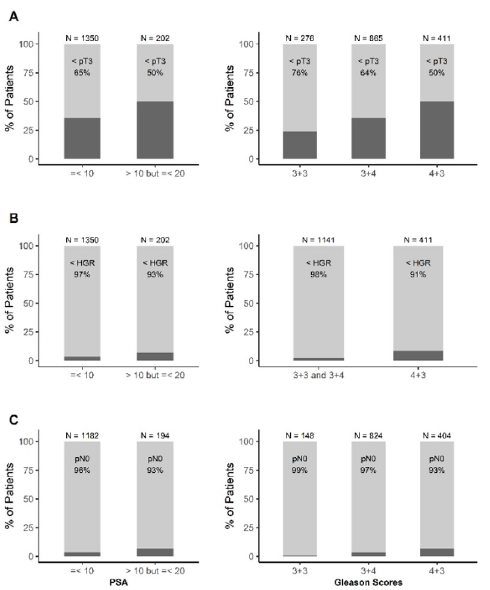
Fig 1. Incidence of adverse pathological features among subsets of patients. A) percentage of cases with pathological upstage to pT3 or higher disease among men with different PSA levels and GS at the biopsy. B) the percentage of cases with pathological upgrade to GS 8 or higher among men with different PSA levels and GS at the biopsy. C) the percentage of cases with pathological node positive disease among men with different PSA levels and GS at the biopsy.